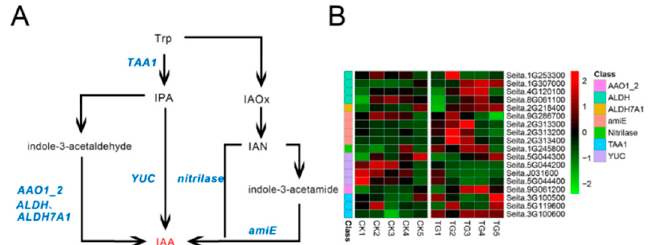
Figure 7. Auxin biosynthetic pathway and di ff erentially expressed genes. ( A ) Auxin biosynthetic pathways. ( B ) Heatmap of di ff erentially expressed genes related to this pathway. The FPKM (Fragments per kilobase of exon model per million mapped fragments) value of the gene was normalized by Pheatmap package in R language before the heatmap was drawn. In the color legend on the right side of the heatmap, the color labels of each gene correspond to the bar graph on the left side of the heatmap. The experiment was repeated at least three times and the results were similar. The heatmap data are the average of the repeated FPKM